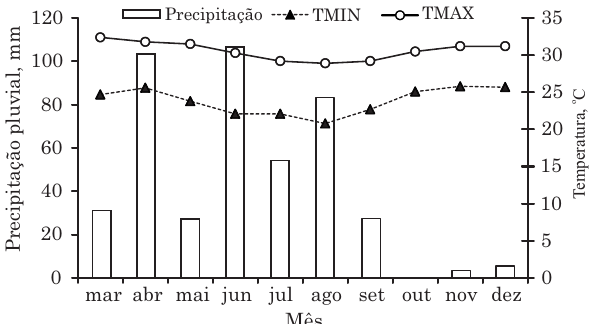
Figura 1. Precipitação pluvial e temperaturas mínima e máxima do ar registrados durante o Quadro 1. Características químicas e físicas do solo da área experimental, na profundidade de 0-20 cm, antes da instalação do experimento